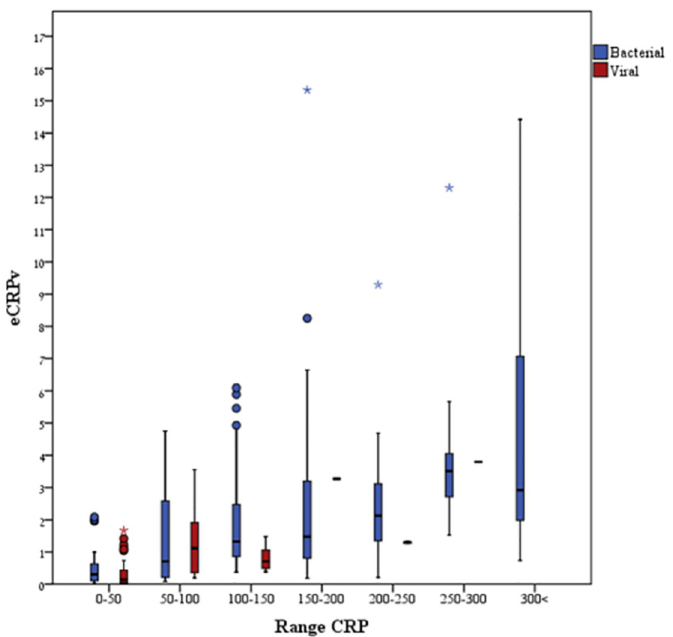
Fig 5. eCRPv values for the groups of patients with iso-CRP levels. Higher eCRPv values were observed almost exclusively among patients with CRP levels > 150 mg/L who had validated bacterial infections.